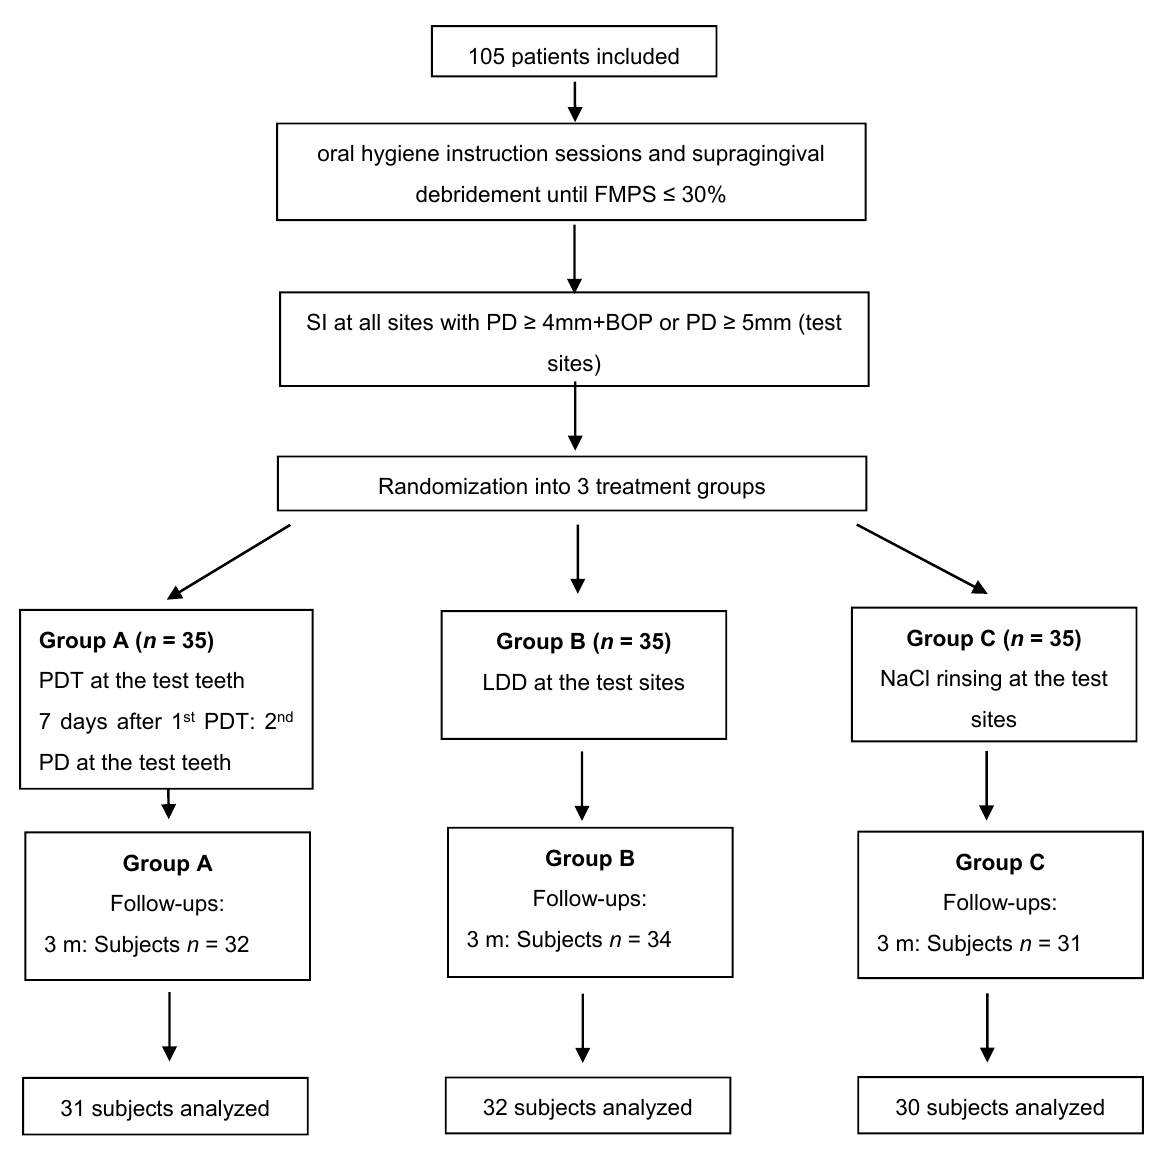
Figure 1. Flowchart of the study (FMPS: full mouth plaque score; SI: subgingival instrumentation; LDD: local drug delivery; PDT: photodynamic therapy). Table 1. Demographics at baseline of n = 105 patients randomized into three groups (A: PDT, B: LDDs, C: control) of n = 35 patients each.